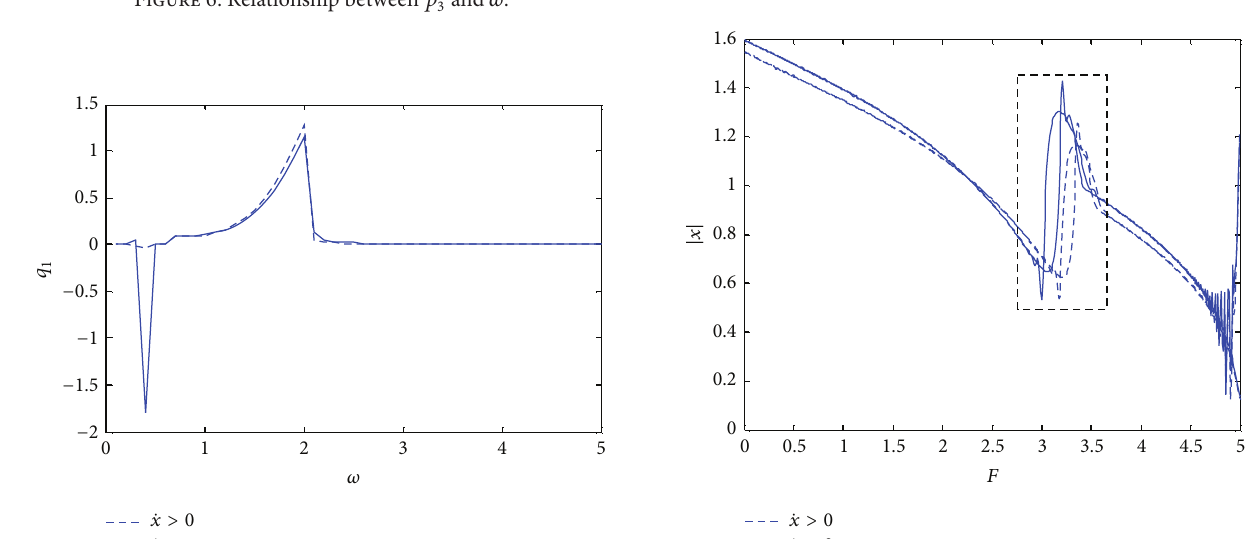
Figure 7: Relationship between 𝑞 1 and 𝜔 .